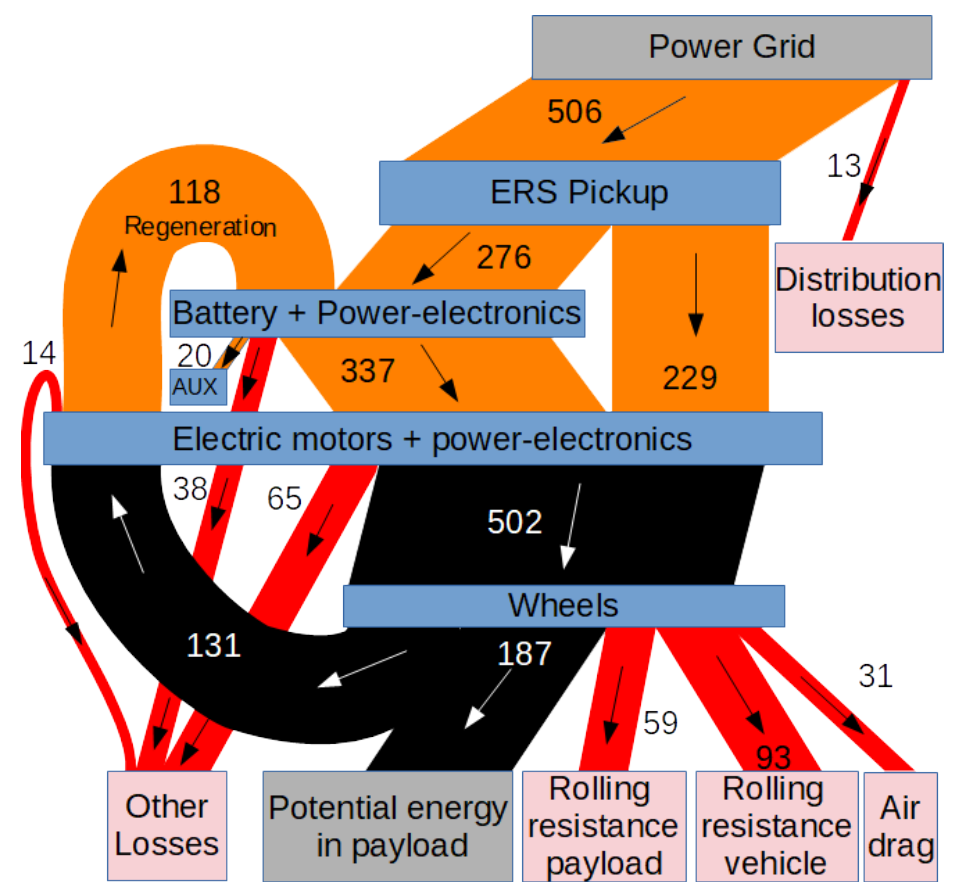
Figure 13. Average energy flows in the “Battery + ERS” drivetrain in a mix of drive cycles according to Table